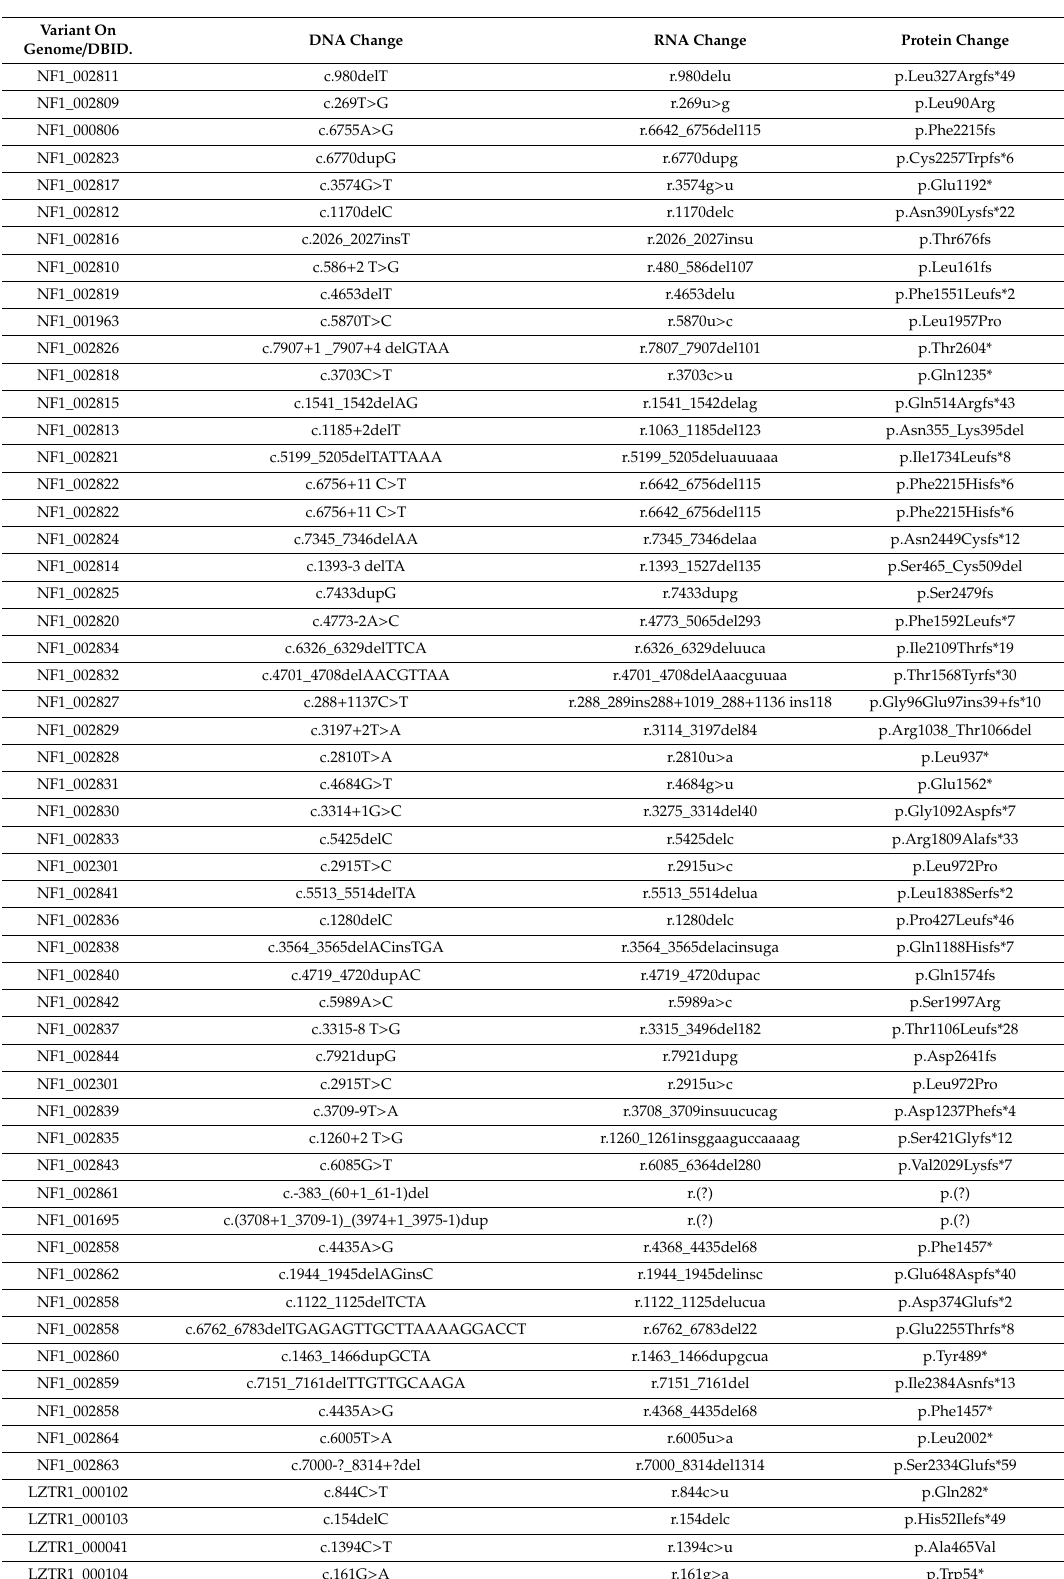
Table 1. New NF1 and LZTR1 pathogenic variants observed. Variant On Genome /